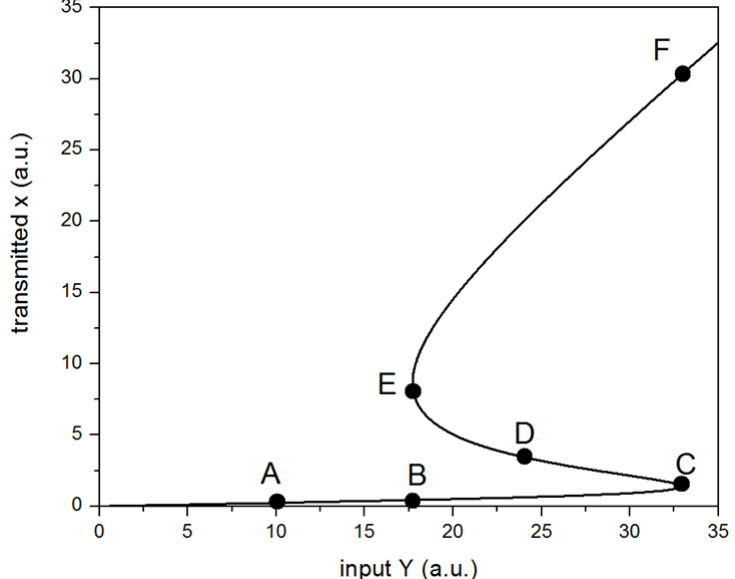
Figure 2 . Stationary curve of bistability calculated from relation